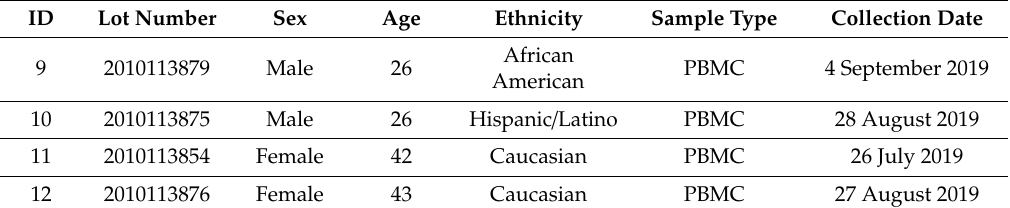
Table 2. Healthy PBMCs for infection with dual-tropic 89.6 HIV-1 and induction of